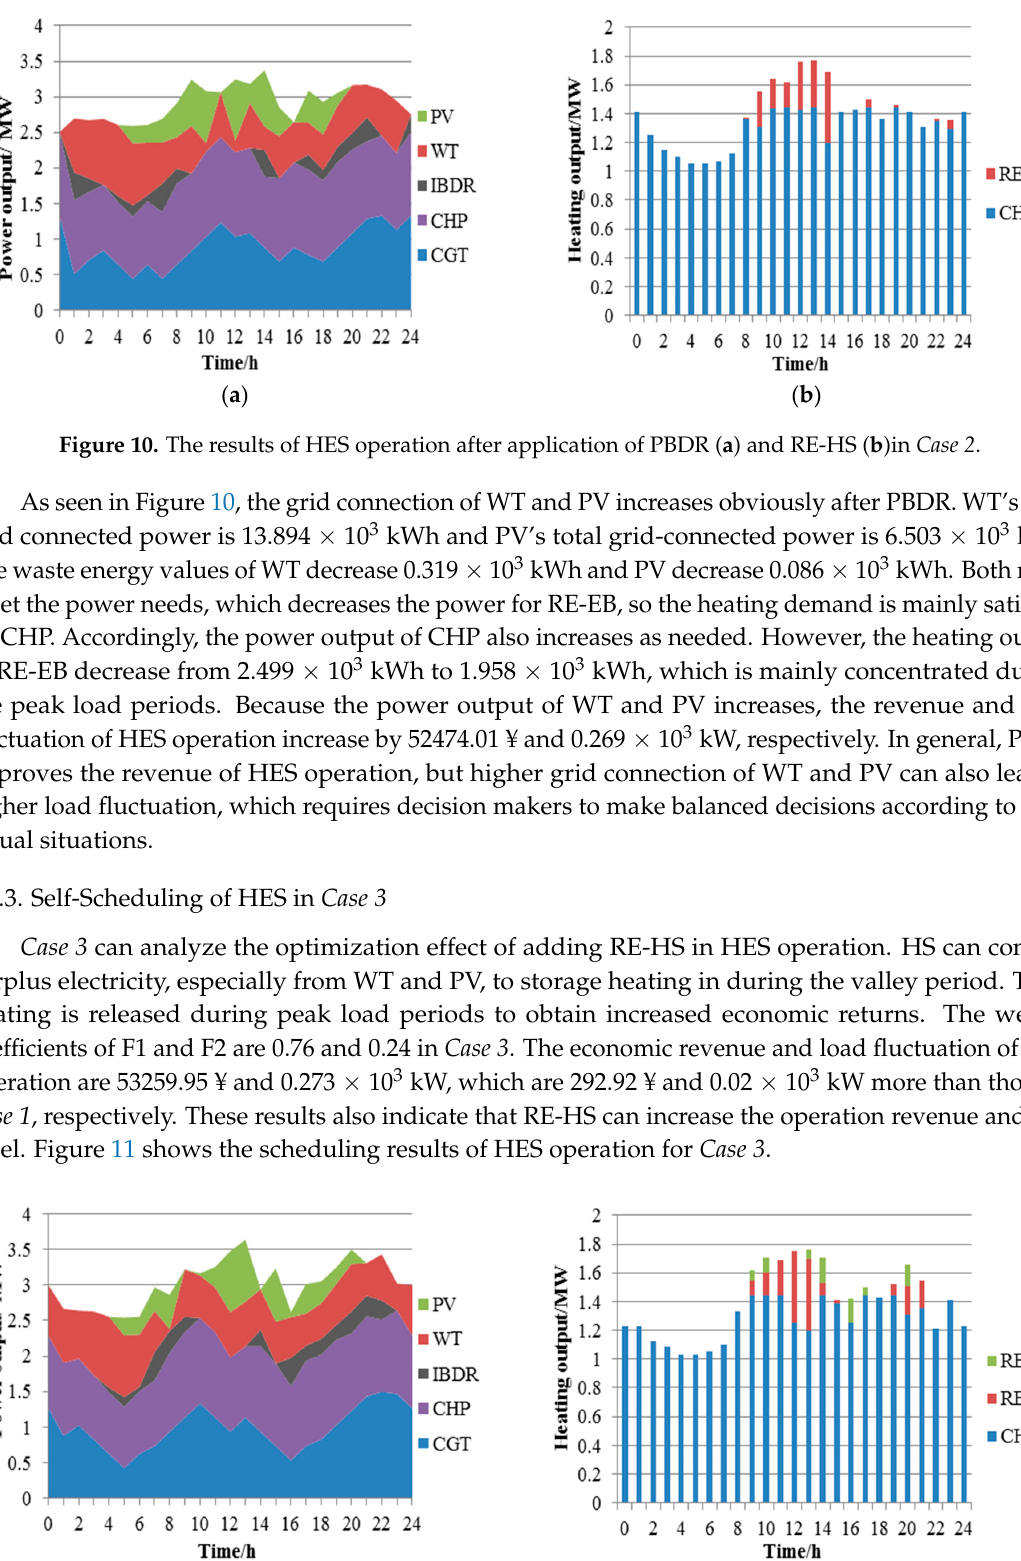
Figure 11. Scheduling result of HES operation after application of PBDR ( a ) and RE-HS ( b ) for Case 3 .